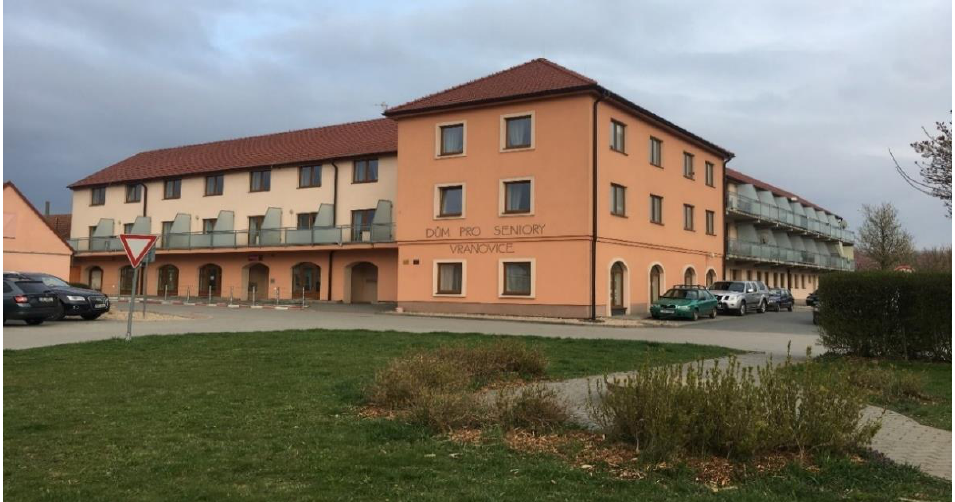
Figure 4. Social care home for elderly people, built on the site of a former socialist agricultural co- operative in Vranovice. Source: K. Charvátová (2021).